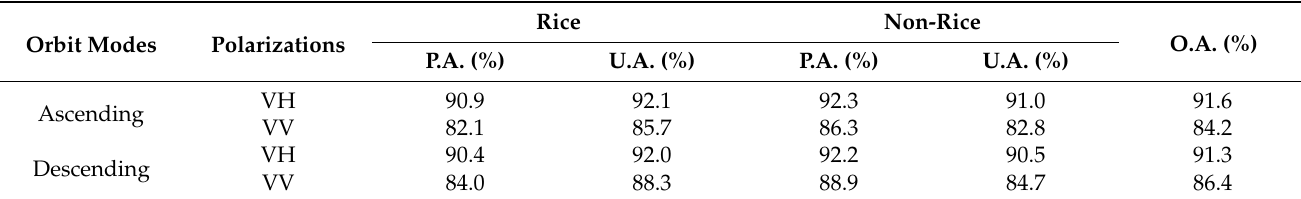
Table 4. Detection accuracy of all combined features for different orbit modes and polarizations. Rice Orbit Modes Polarizations